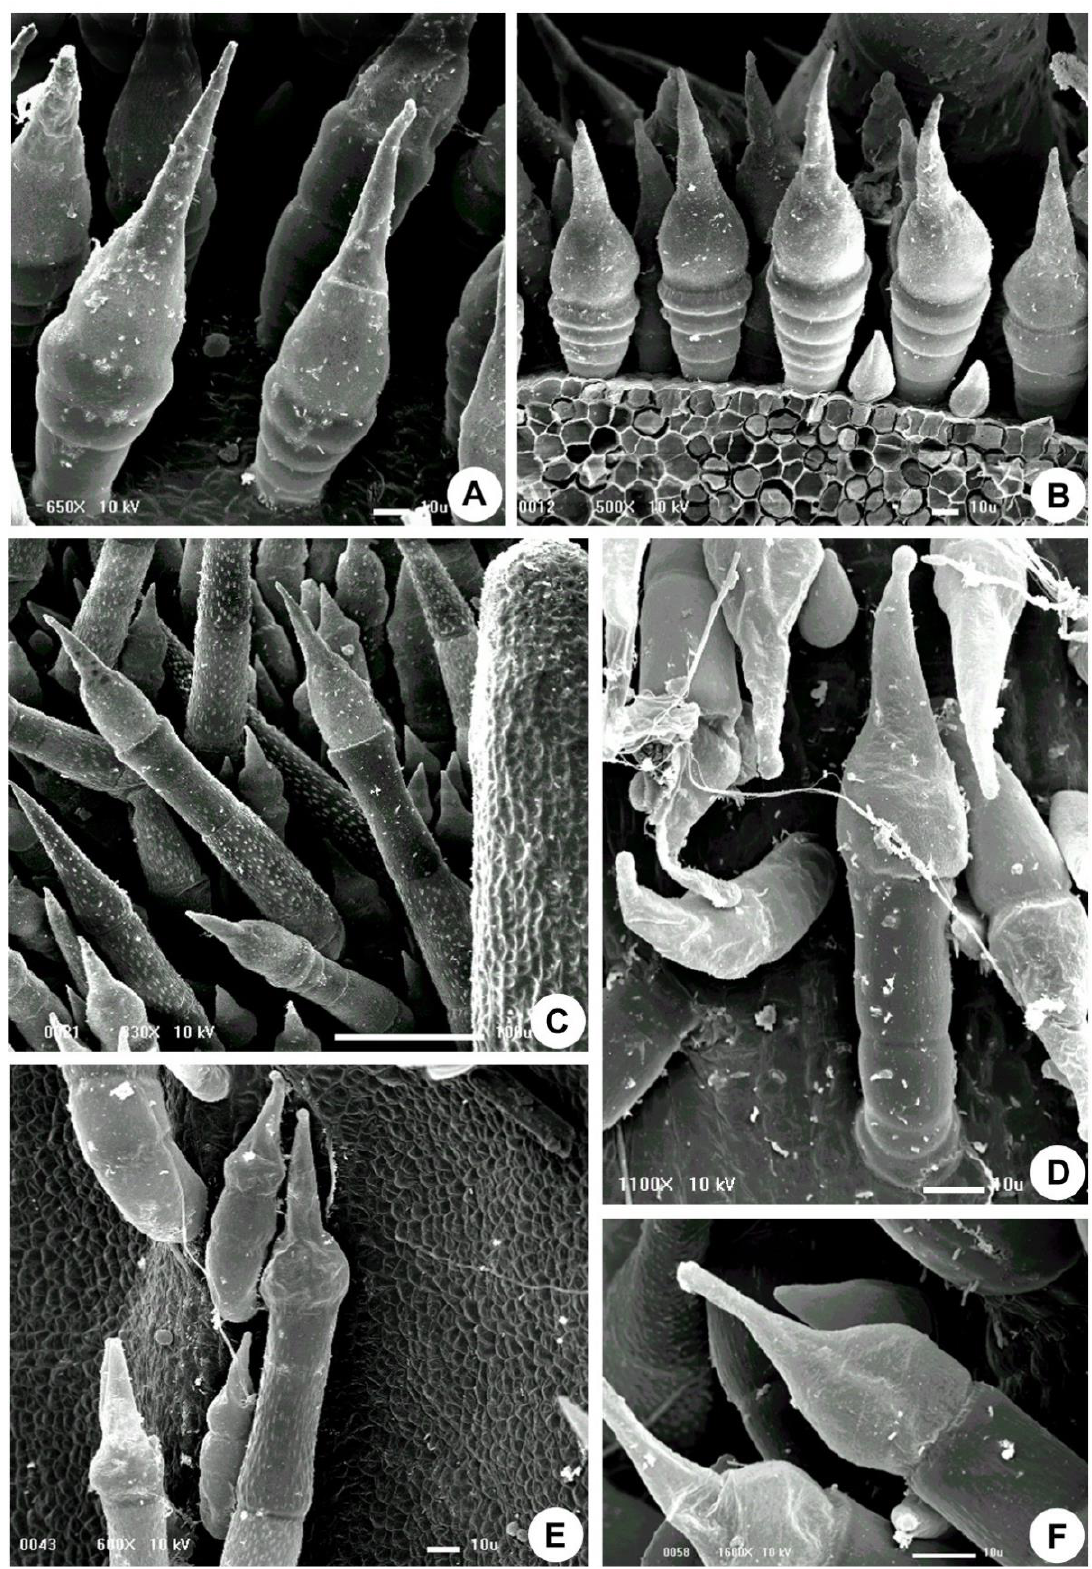
Figure 1. Scanning electron micrographs of the stinging trichomes of Apocynaceae. ( A – C ) Fischeria stellata . ( D – F ) Matelea denticulata ( A , D ) Stem. ( B , C , E , F ) Leaf.